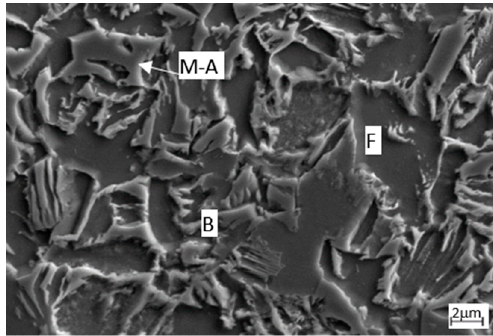
Figure 11. Heat treatment parameters: Soaking 850 °C/100 s, cooling rate 30 °C/s, bainitic hold 400 °C/600 s. Bainitic-ferritic microstructure with M-A constituent.